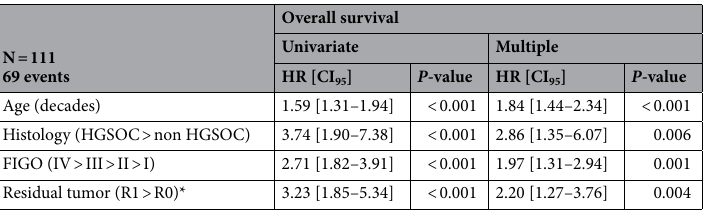
Table 3. Univariate and multiple Cox regression overall survival analyses in 111 patients with ovarian cancer. CI 95 , 95% confidence interval. *Using a cut-off of 0 cm for R1 in the multiple Cox regression model showed no significant independent impact on OS any more (HR 1.44, p = 0.170).